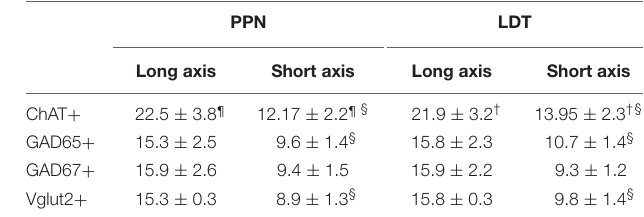
TABLE 1 | Morphometric analysis of PPN and LDT subpopulations ∗